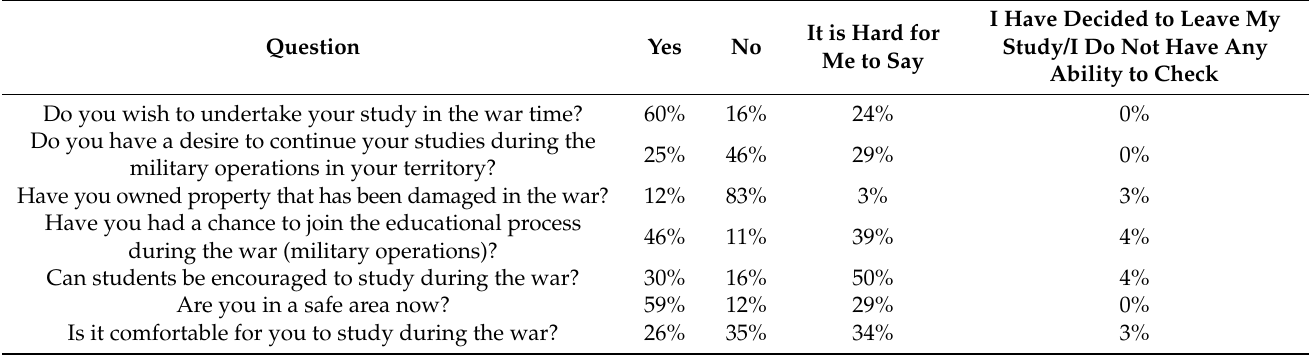
Table 4. The Students’ Attitudes to Studying During the